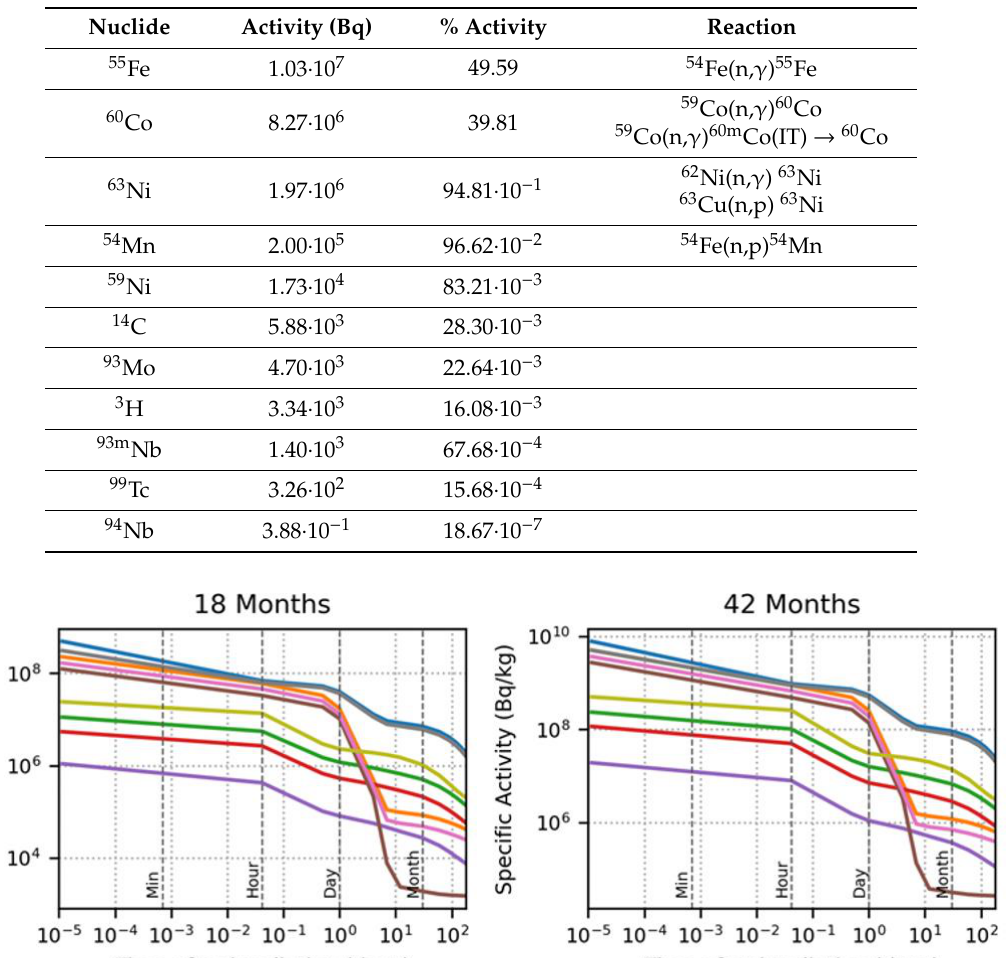
Table 6. Activation after 10 years of cooling time for the Megavolt ITER Injector and Concept Advancement (MITICA) dump, from D-D reactions.